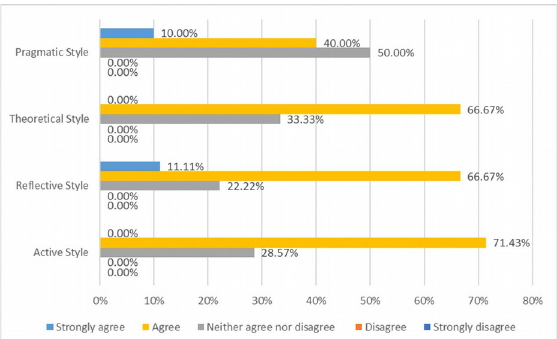
Figure 11. In class we work more on critical thinking